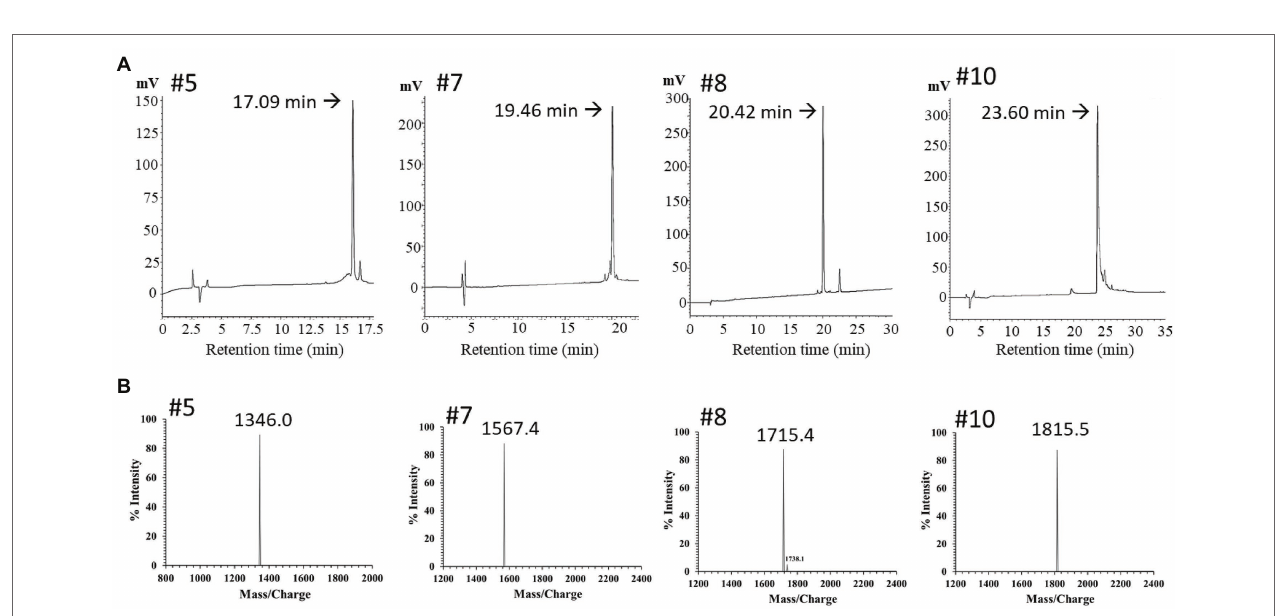
FIGURE 4 | RP-HPLC and mass spectrum of purified peak peptides (PN-#5, PN-#7, PN-#8, and PN-#10). Chromatogram of AMPs in the 40% ACN fraction obtained using HPLC (A) ; Mass spectra of purified peak peptides using MALDI-TOF/MS (B)